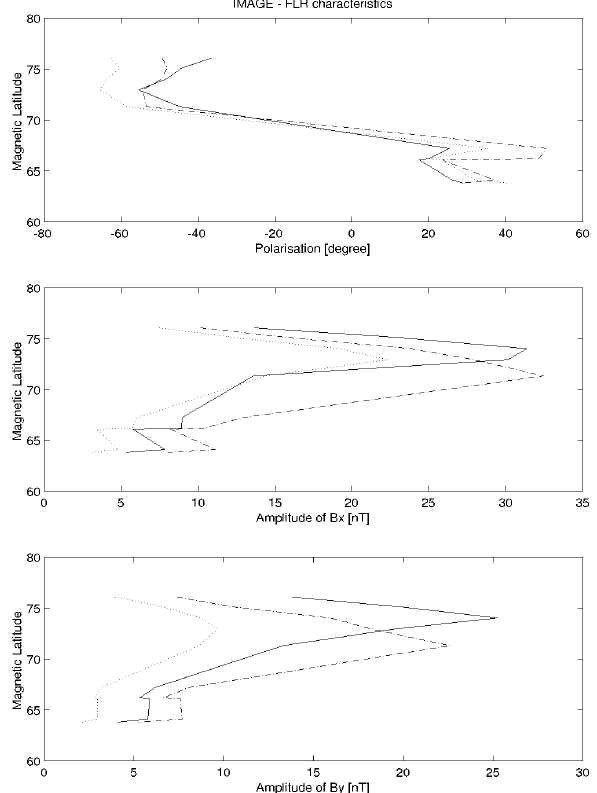
Fig. 6. Power spectra of various parameters. From top to bottom: X -component of the ground magnetic field measured at LYR, idem at KEV, electron temperature measured at 300km of altitude by the ESR, idem for ion temperature, magnitude of the magnetic field recorded at Geotail, and solar wind dynamic pressure recorded at IMP-8.